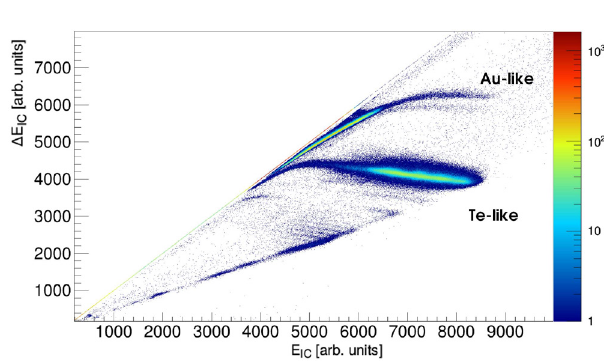
Figure 1. Matrix of ∆ E versus E measured in the PRISMA ionization chamber (IC) for the 197 Au + 130 Te reaction at E lab ( 197 Au) = 1 . 07 GeV and θ lab = 37 ◦ . The most intense band corresponds to Te-like ions, while Au-like ions are located in the region where ∆ E IC and E IC merge. One can also see the ions corresponding to fission-like events which are not stopped in the IC.